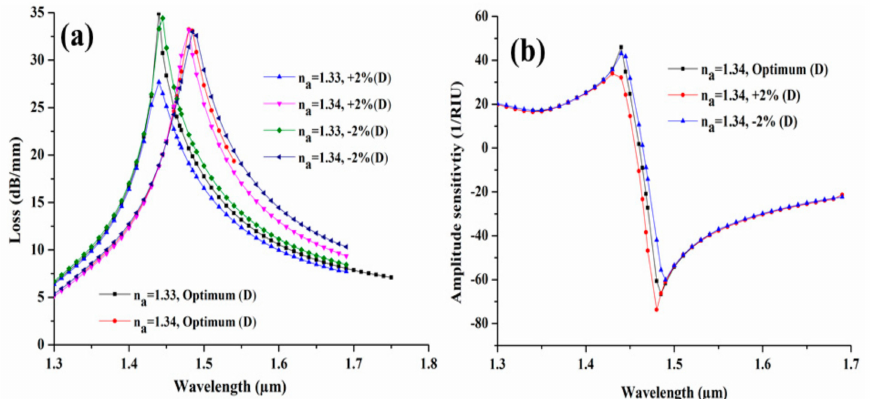
Figure 9. ( a ) Loss spectra and ( b ) amplitude sensitivity, with ± 2% variation in separation of CSC from core.